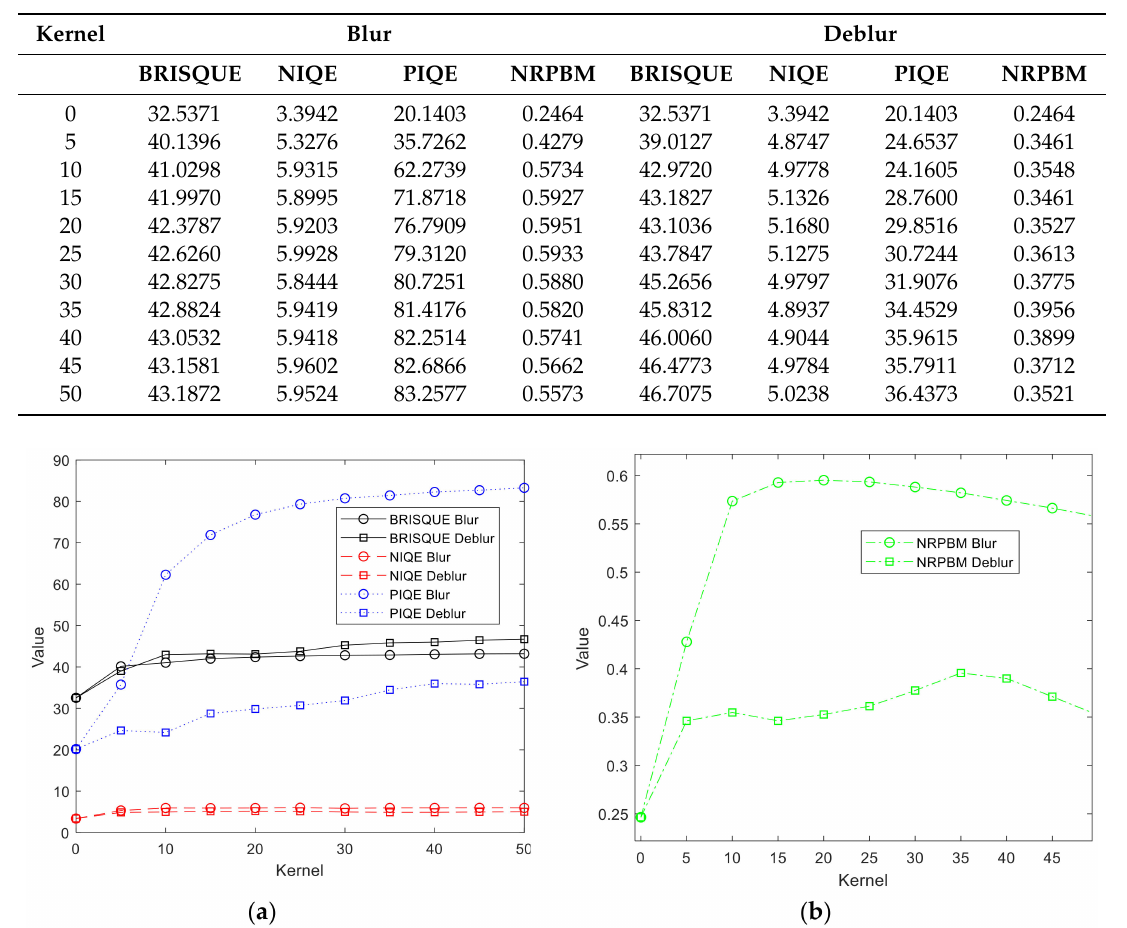
Figure 6. Image quality evaluator score changes: ( a ) blind referenceless image spatial quality evaluator (BRISQUE), natural image quality evaluator (NIQE) and perception-based image quality evaluator (PIQE); ( b ) no-reference perceptual blur metric